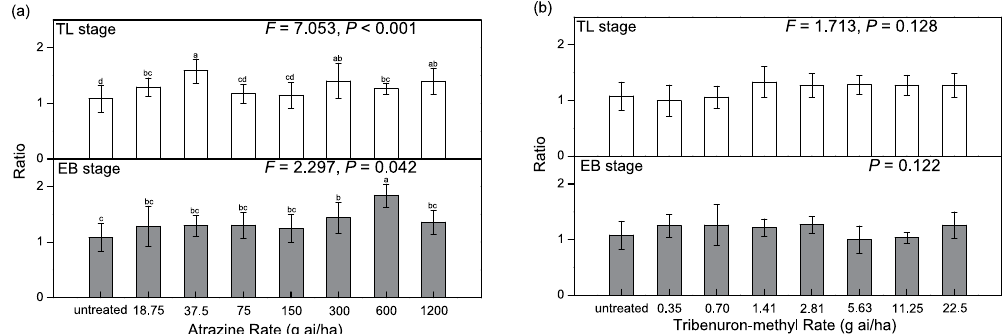
Figure 3. Ratio of radicle length to hypocotyl length of 7-day-old seedlings produced after the 12 to 14 true leaves stage (TL stage) and the early blooming stage (EB stage) treated with atrazine ( a ) or tribenuron-methyl ( b ).